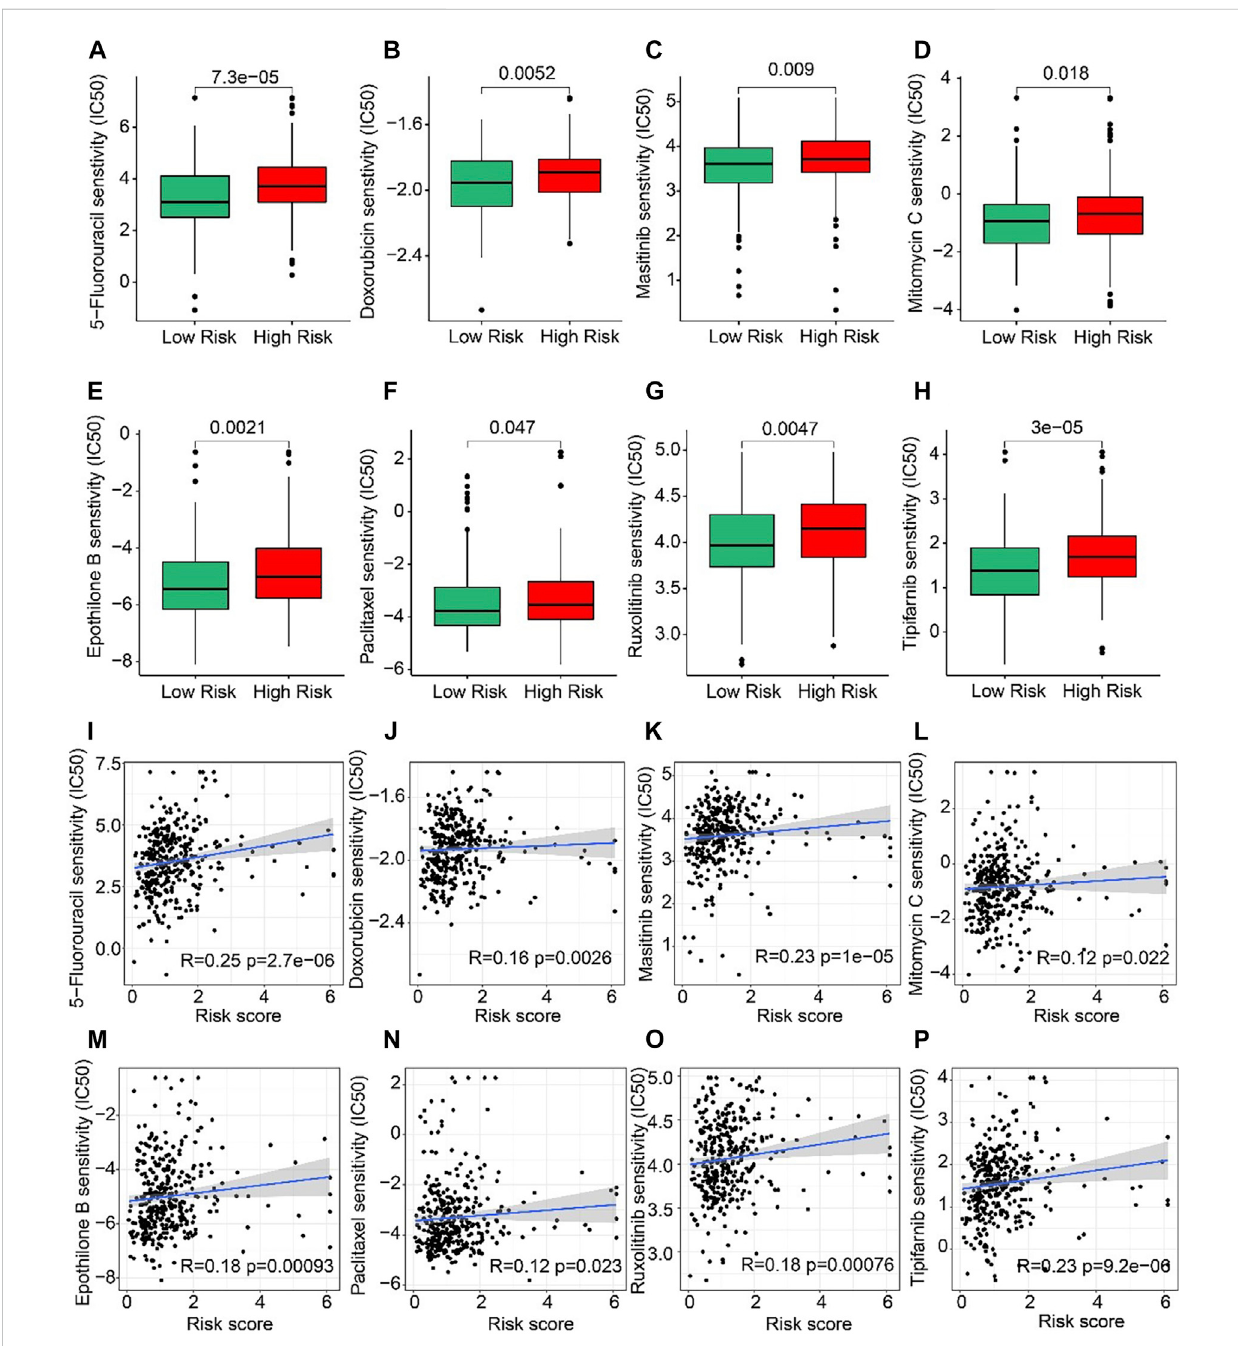
FIGURE 8 Drug sensitivity of patients in the low- and high-risk group. (A) 5-Fluorouracil, (B) Doxorubicin, (C) Masitinib, (D) Mitomycin C, (E) Epothilone, (F) Paclitaxel, (G) Ruxolitinib, and (H) Tipifarnib. Zhang et al. (2022) (I – P) Correlation analysis of the risk score and drug sensitivity